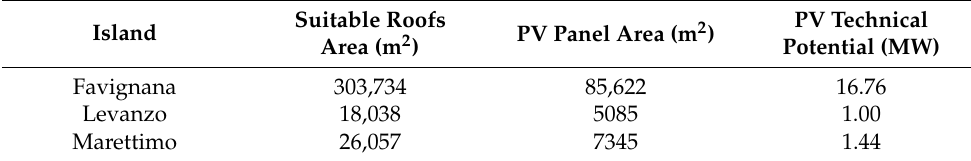
Table 11. Egadi PV technical potential on rooftops. Suitable Island